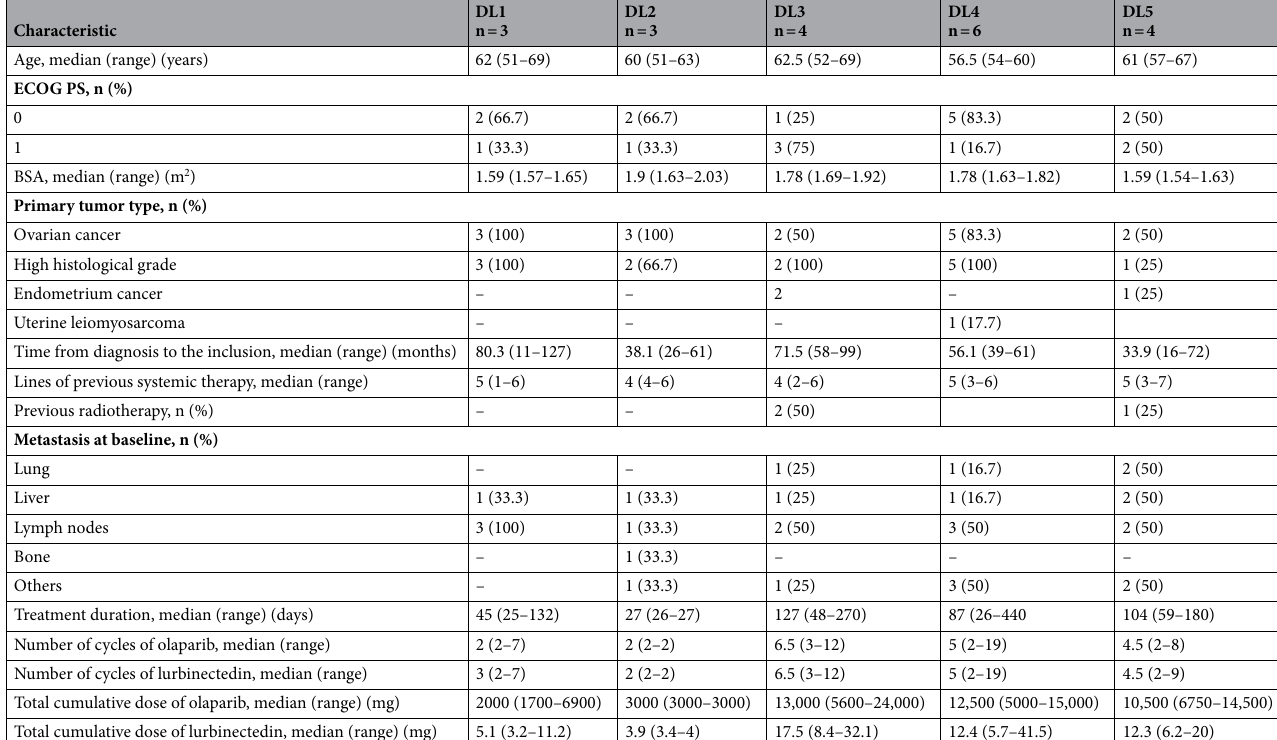
Table 1. Patient characteristics. BSA body surface area, DL dose level, ECOG PS Eastern Cooperative Oncology Group Performance Status.